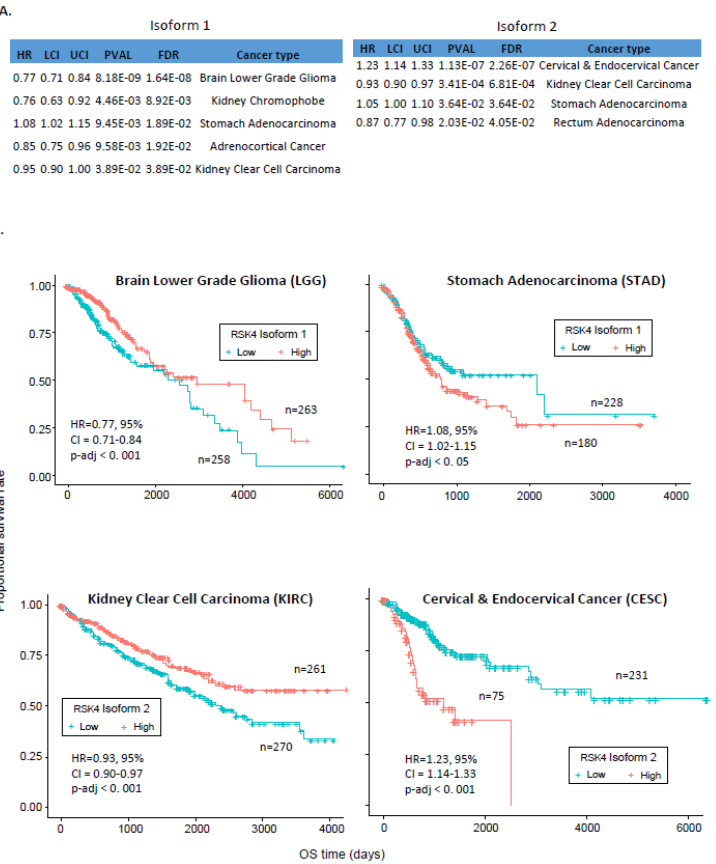
Figure 3. Expression of RSK4 isoform 1 or 2 correlates with overall survival in some cancer types. ( A ) Results from univariate analysis correlating the expression of isoforms 1 (left) and 2 (right) with overall survival across 33 cancer types. Only cases with significant correlation (FDR ≤ 0.05) are shown. Estimates of the Hazard Ratio (HR) and the Upper (UCI) and Lower (LCI) Confidence Intervals are shown. ( B ) Kaplan – Meier survival curves showing the correlation of high (red) and low (blue) expression of isoform 1 or 2 with overall survival in LGG, STAD, KIRC, and CESC patients. Median expression was used as cut-off.